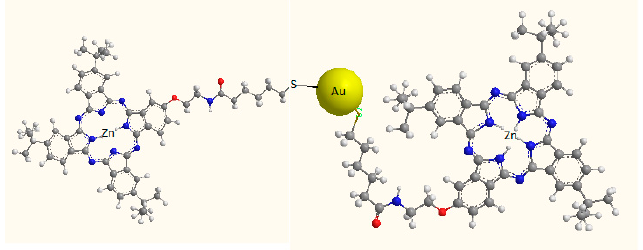
Figure 1. Representation of the AuNP NBr -S-ZnPc R